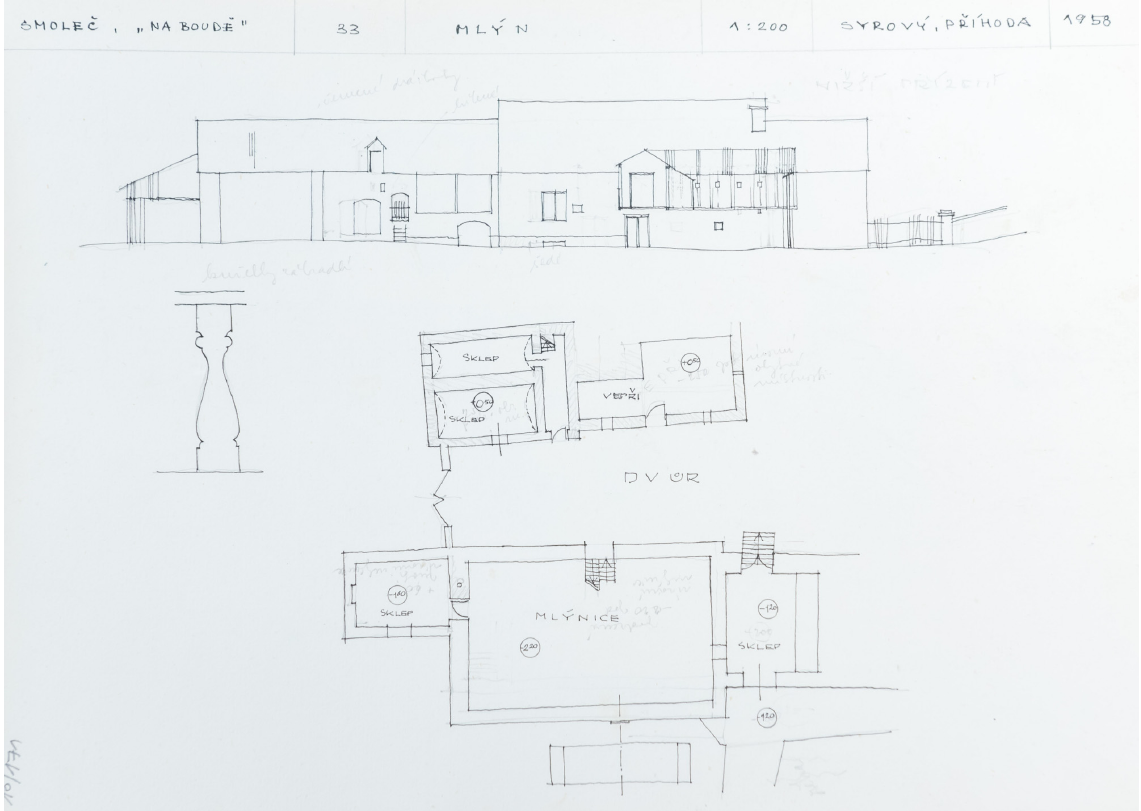
Figure 8. Depiction of rescue survey documentation, Source: Masaryk Institute and Archive of the CAS.